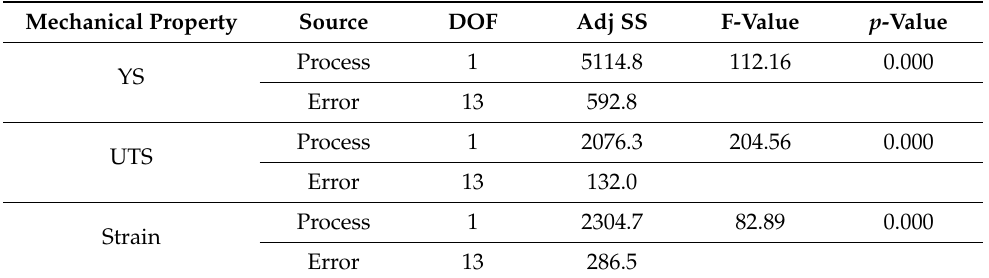
Figure 5. Tensile properties of the annealed and LFPed aluminum specimens in the laser scanning (LFP-X) and part building (LFP-Z) directions. Table 1. ANOVA analysis of tensile test data for LFP and annealed specimens.